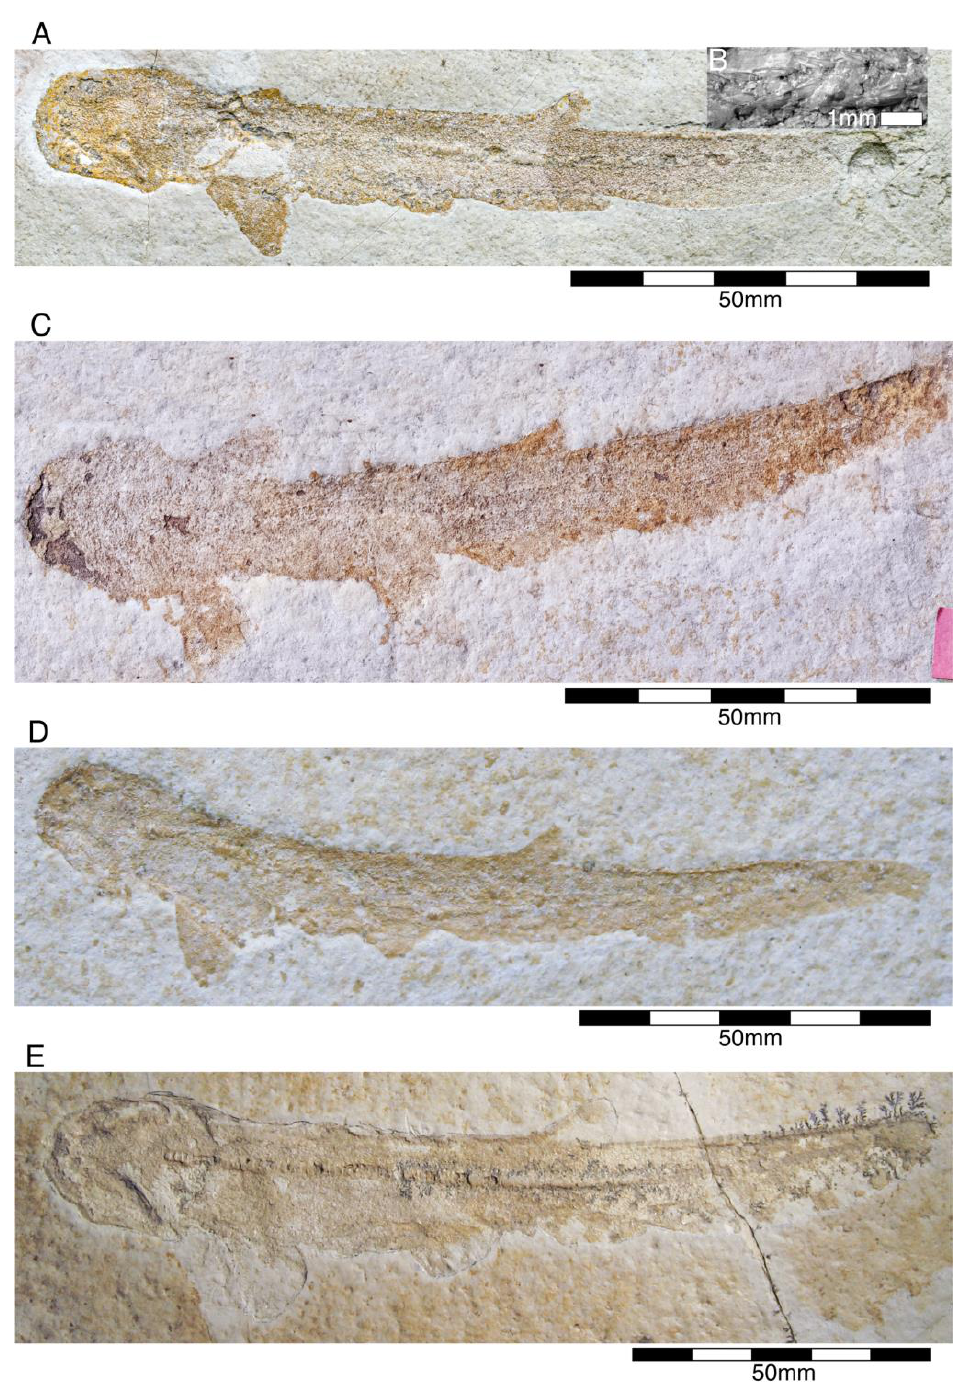
Figure 16. † Macrourogaleus hassei Fowler, 1947 [211] ( A ) Holotype specimen (SNSB-BSPG AS I 1363) from the lower Tithonian of Eichstätt. ( B ) Close up to the enlarged denticles in the upper lobe of caudal fin. ( C ) Holomorphic specimen (SNSB-BSPG AS I 1362) from the lower Tithonian of Eichstätt. ( D ) Holomorphic specimen (JME SOS 2209) from the lower Tithonian of Eichstätt. ( E ) Holomorphic specimen (AMNH 7498) from the lower Tithonian of Eichstätt. The body and fin shapes indicate that this small shark was probably strictly benthic, predominantly inhabiting the very structured sponge and microbial reefs surrounding the